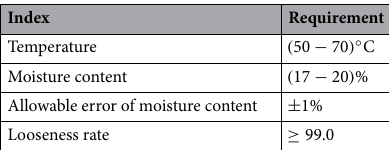
Table 2. Hot-air tobacco leaves moisture index and requirement.